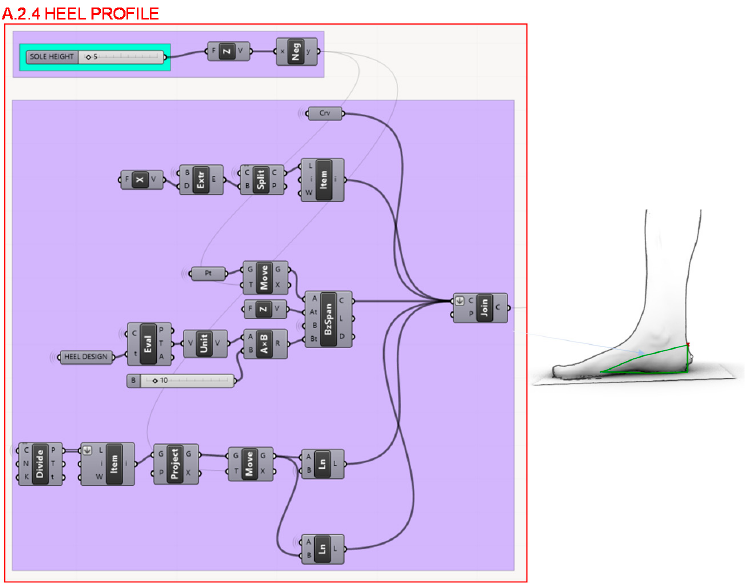
Figure 12. Programming structure definition developed to determine the heel profile.